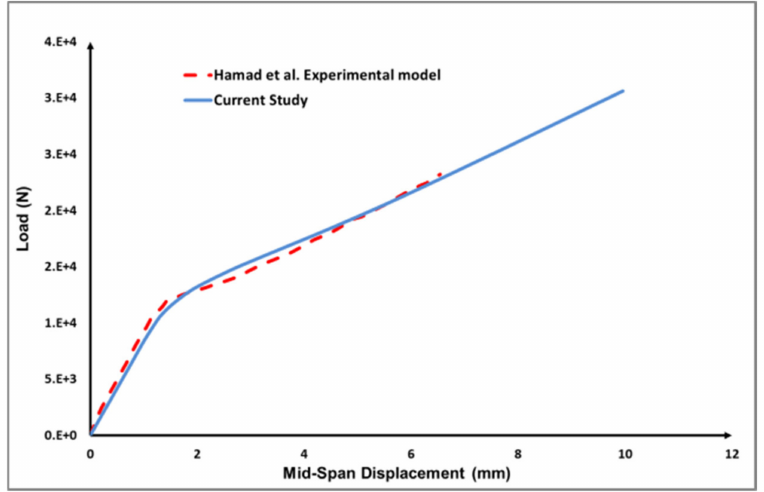
Figure 3. Static response in ABAQUS correlation with the empirical results [26].